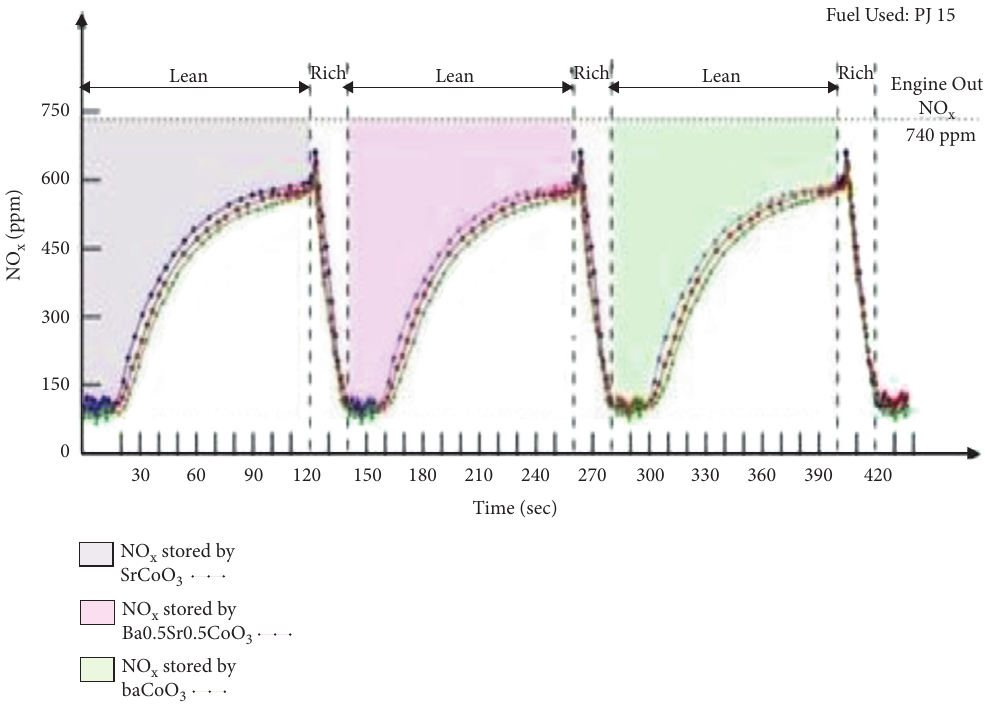
Figure 18: Average NO